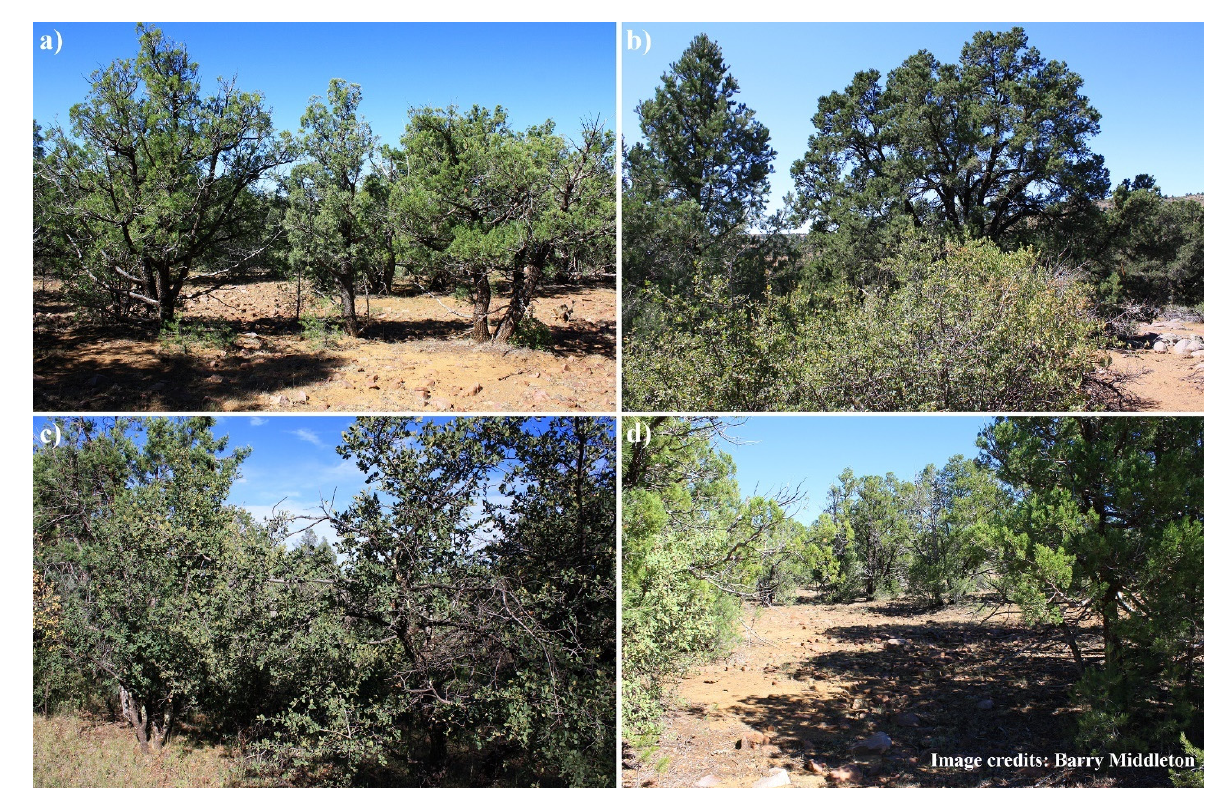
Figure 1. Common trees in pinyon–juniper–evergreen oak woodlands on the San Carlos Reservation, Arizona. ( a ) Juniper trees ( Juniperus deppeana ), ( b ) pinyon pine trees (background), ( c ) evergreen oak trees ( Quercus arizonica ), and ( d ) typical woodland view.